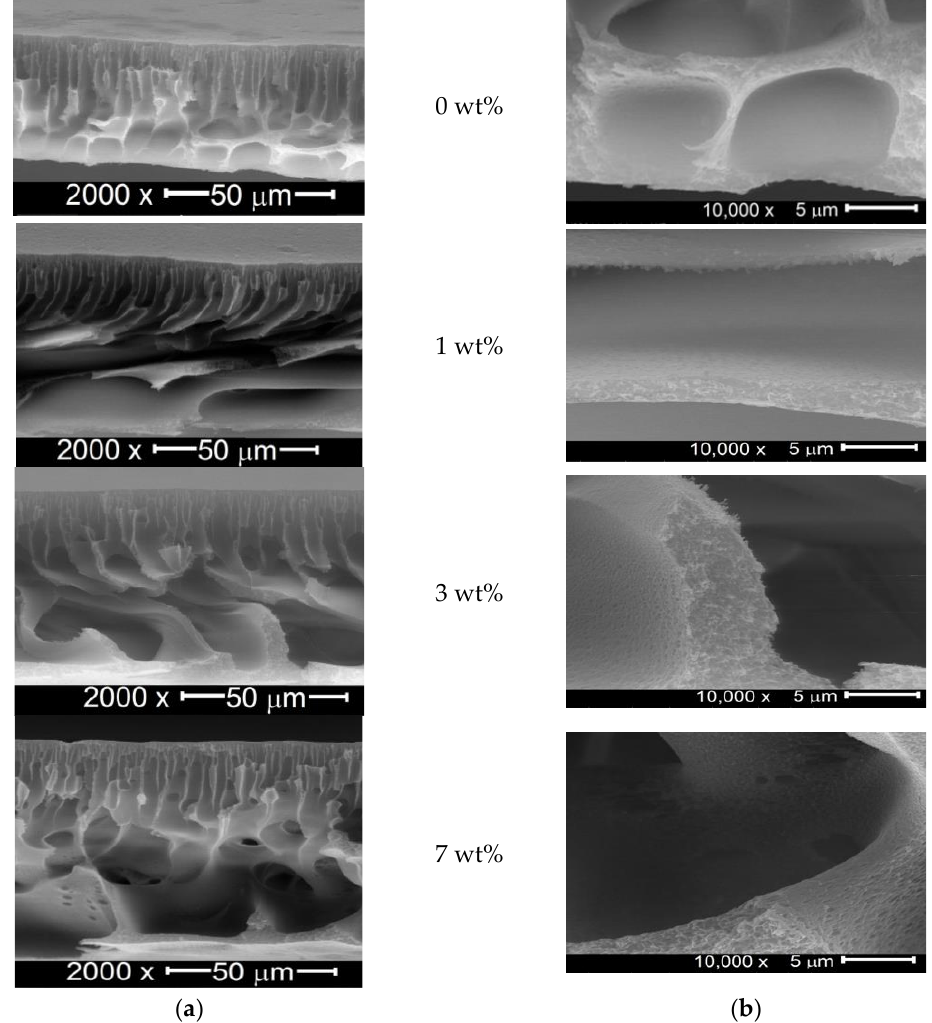
Figure 2. SEM images showing the effect of PO concentration on membrane morphology in cross- section ( a ) and enlarged cross-section near the bottom surface ( b ).